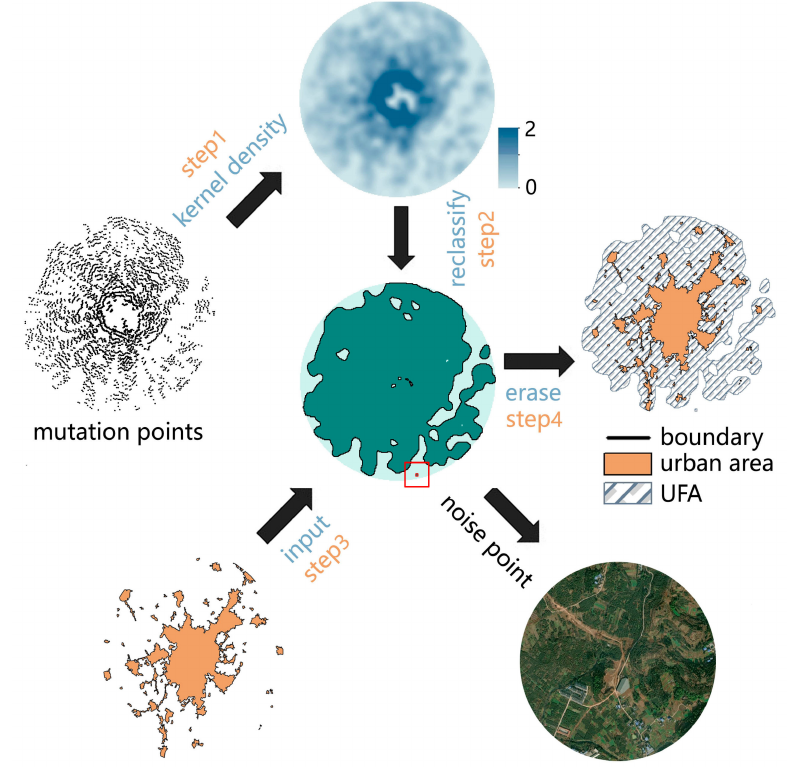
Figure 8. Process of defining the extent of